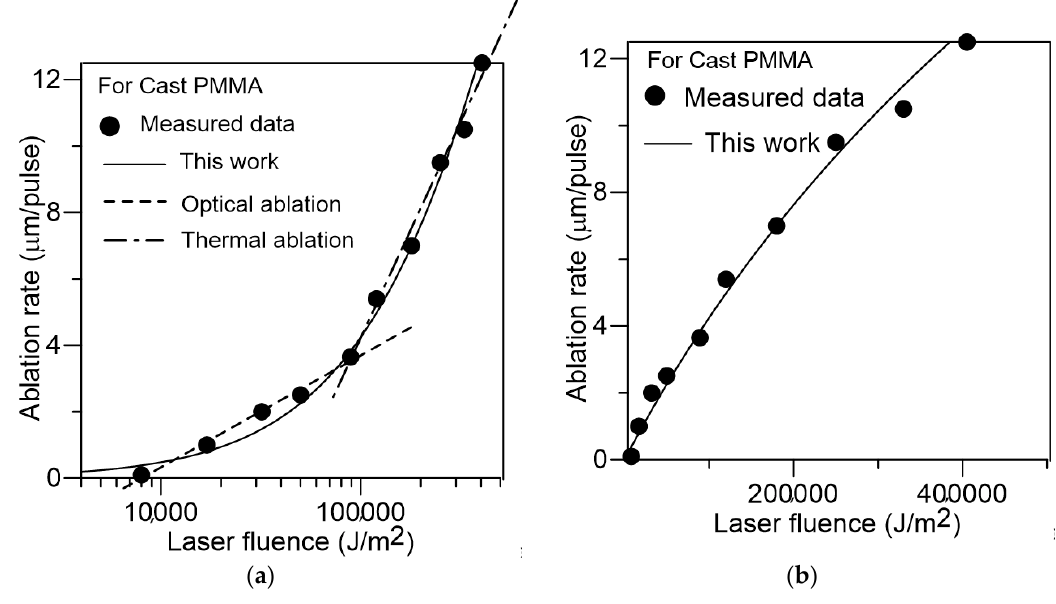
Figure 1. Ablation rate versus laser fluence of poly(methyl methacrylate) (PMMA) for the solid line predicted by this work and the circle symbols measured by the published paper [13] ( a ) with the horizontal axis of the logarithm scale, and ( b ) with the horizontal axis of the linear scale.